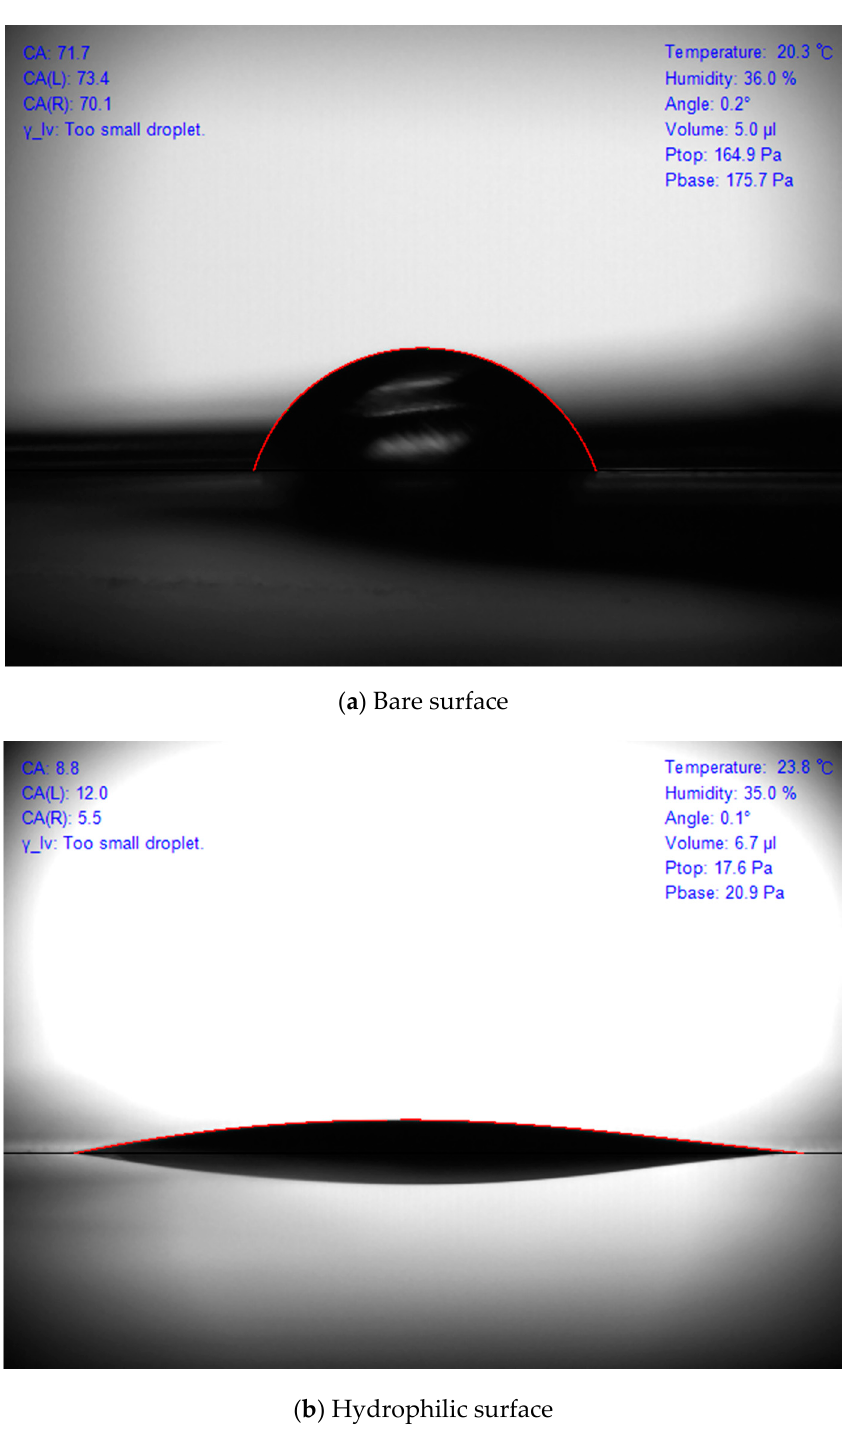
Figure 3. Surface contact angle of the copper surface.